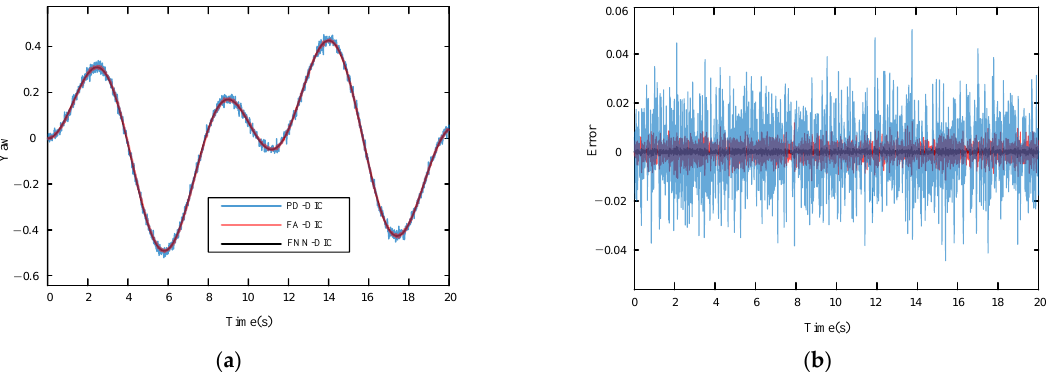
Figure 12. Pitch angle tracking results under atmospheric disturbance: ( a ) Pitch angle tracking curve, and ( b ) tracking error curve.